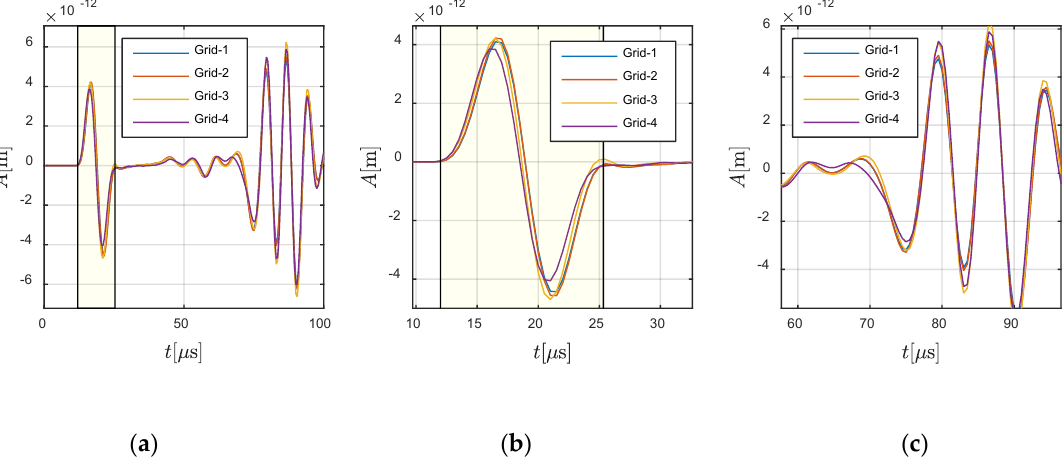
Figure 12. Responses in Y- direction at − 0.0625 m and 0 m in the solid region: ( a ) global view and ( b , c ) local views. The highlighted part defines the theoretical wavefront and duration of S-wave.